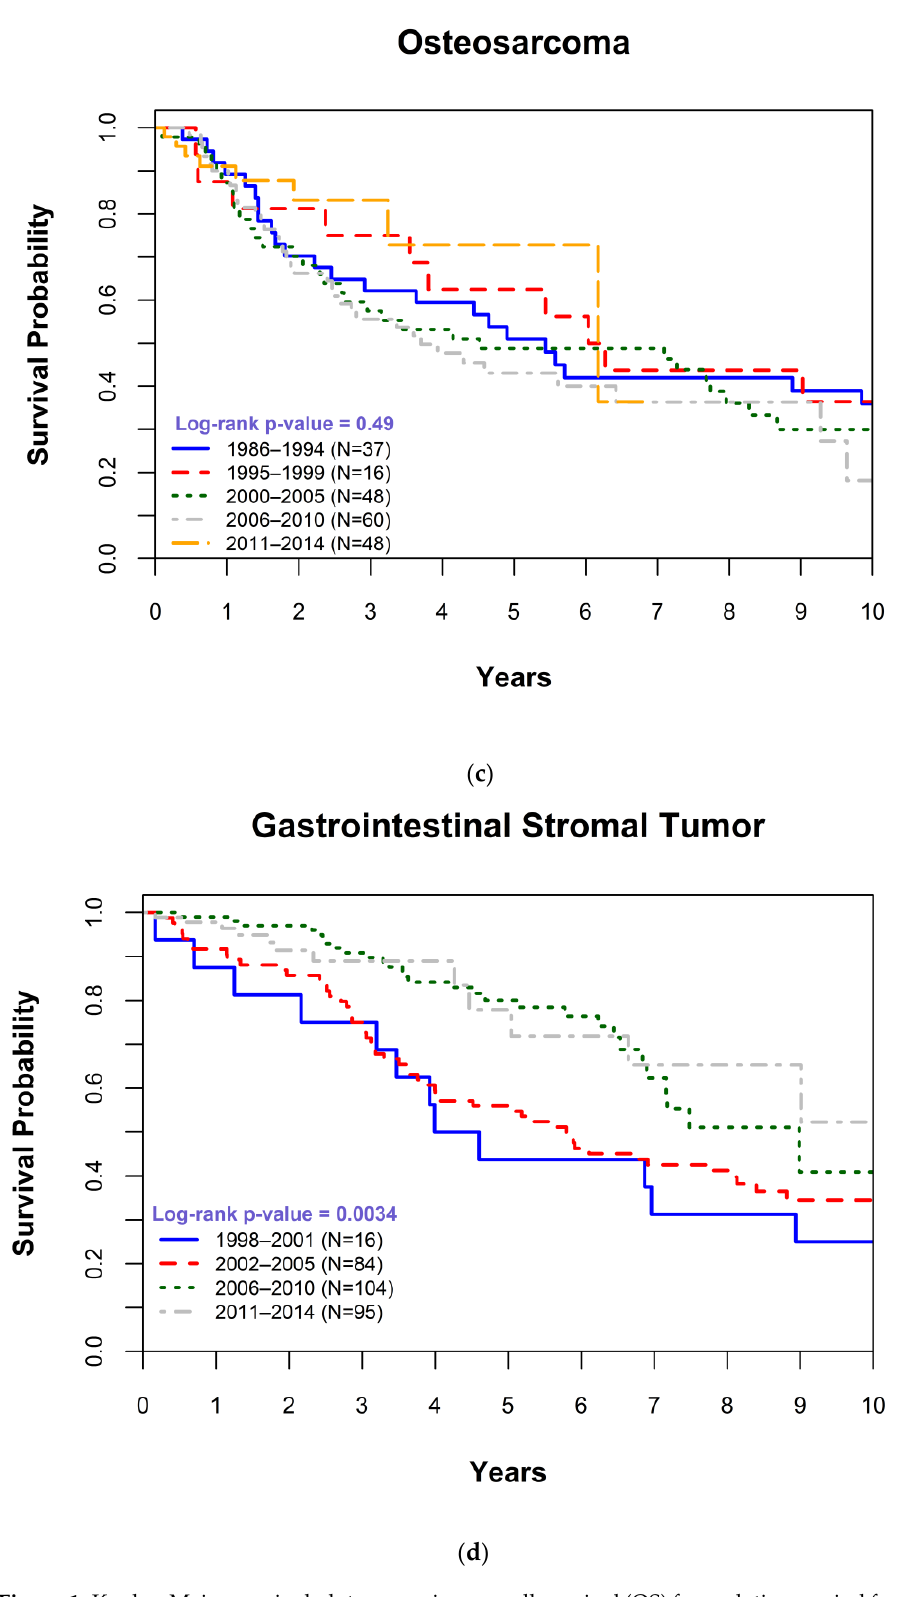
Figure 1. Kaplan-Meier survival plot comparing overall survival (OS) for each time period for patients with ( a ) bone sarcomas, ( b ) soft tissue sarcomas, ( c ) an osteosarcoma, and ( d ) a gastrointestinal stromal tumor. OS was right-censored at 10 years associated and p -values were determined using log-rank statistics.